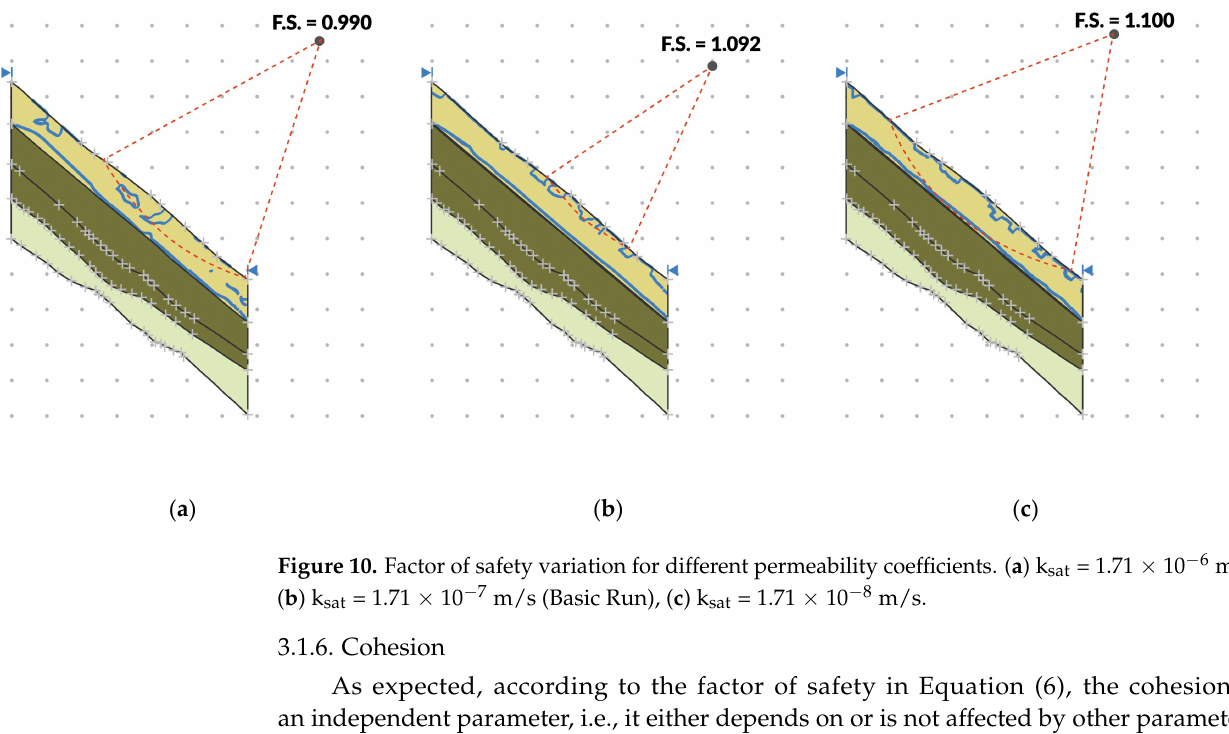
Figure 10. Factor of safety variation for different permeability coefficients. ( a ) k sat = 1.71 × 10 − 6 m/s, ( b ) k sat = 1.71 × 10 − 7 m/s (Basic Run), ( c ) k sat = 1.71 × 10 − 8 m/s. Researchers [60] stated that the pore water pressure variation due to rainfall was found to take place over a wider range in soils with higher coefficient of permeability as